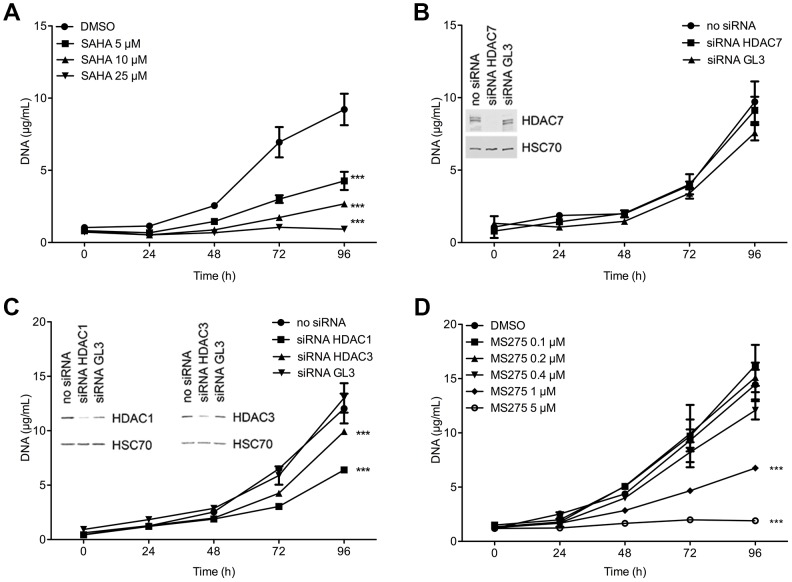
Effect of HDAC silencing or inhibition on BxPC-3 cell proliferation.(A) Time-dependent and dose-dependent effects of SAHA on cell proliferation. (B) Time-dependent effect of class IIa HDAC7 silencing on cell proliferation. HDAC7 expression was detected by western-blot 48h after siRNA transfection. HSC70 was used as a loading control. (C) Time-dependent effect of class I HDAC1 or –3 silencing on cell proliferation.. HDAC1 and HDAC3 expression was detected by western-blot 48h after siRNA transfection. HSC70 was used as a loading control. (D) Time-dependent and dose-dependent effects of MS-275 on cell proliferation ***P<.001 versus DMSO or GL3 conditions. Results are expressed as mean ± s.d., n≥3 in each condition.